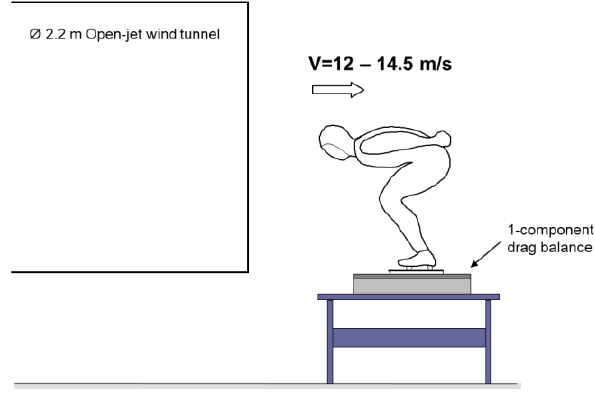
Figure 7. The test setup of the measurements on live skaters in January 1997.